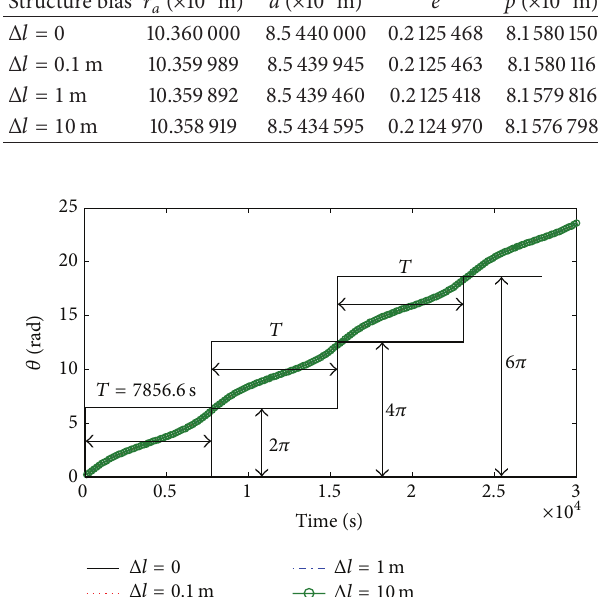
Figure 11: Time history of 𝜃 with different Δ𝑙 , 𝜏 = 250 kN ⋅ m.